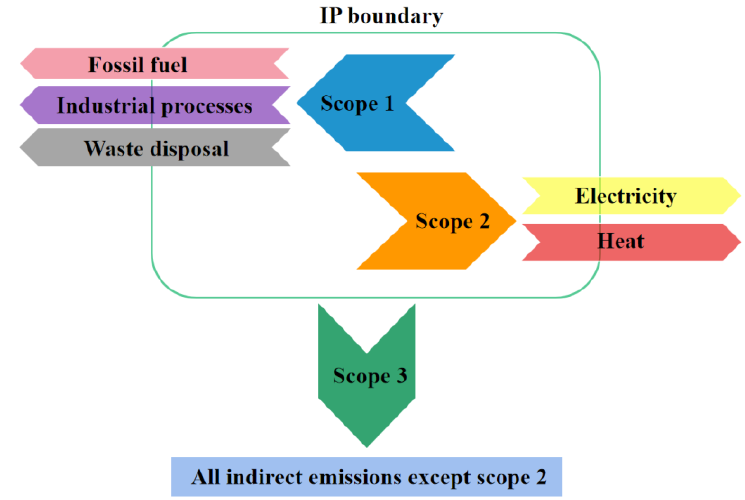
Figure 1. Accounting boundary and scopes of industrial park (IP) CO 2 emissions.